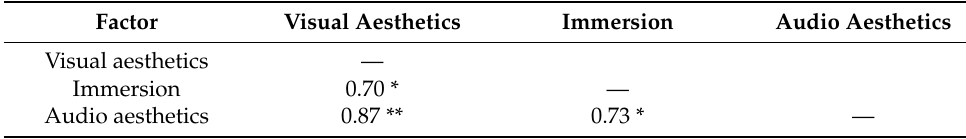
Figure 7. Correlations across three factors of the GUESS, ( a ) audio aesthetics–visual aesthetics, ( b ) aesthetics–immersion, ( c ) visual aesthetics–immersion. * p < 0.05, ** p < 0.01. Table 6. Pearson’s Correlations between GUESS